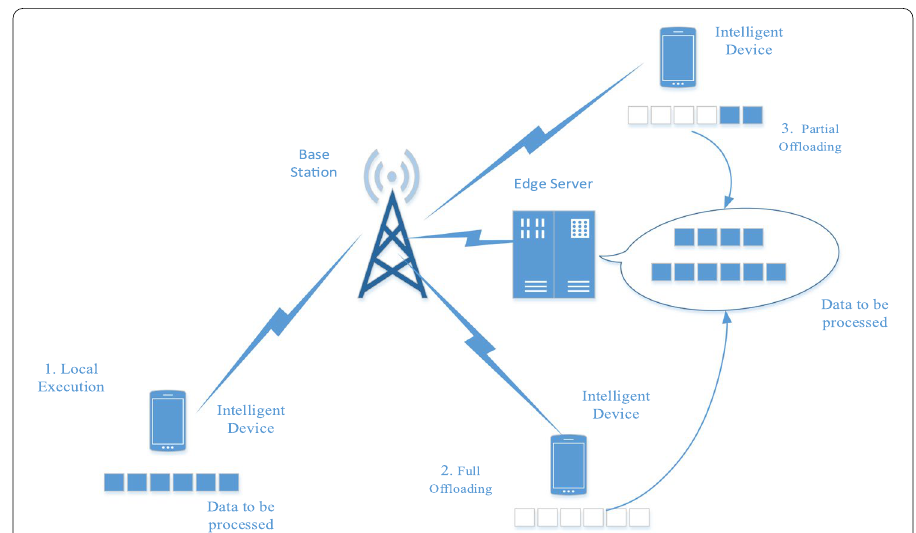
Fig. 1 Task offloading method